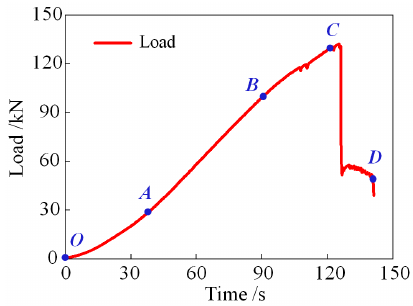
Figure 5. Typical loading curve of concrete specimen.